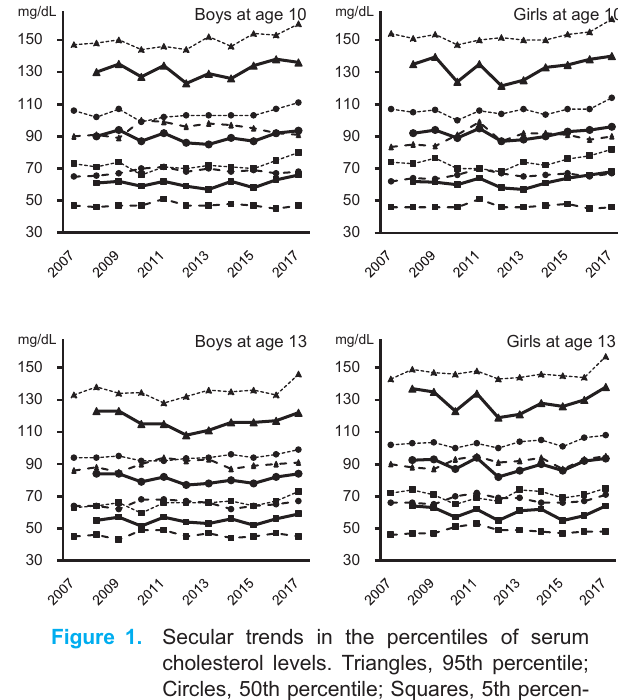
Figure 1. Secular trends in the percentiles of serum cholesterol levels. Triangles, 95th percentile; Circles, 50th percentile; Squares, 5th percen- tile; Solid lines, low-density lipoprotein choles- terol (LDL-C); Broken lines, high-density lipo- protein cholesterol (HDL-C); Dotted lines, non- high-density lipoprotein cholesterol (non-HDL- C). The Jonckheere-Terpstra test was used to evaluate secular trends, with calendar year as the explanatory variable and individual meas- urements as dependent variables. In children aged 10 years, signi fi cant increases were observed in LDL-C ( P = 0.009 in boys, 0.014 in girls), HDL-C ( P = 0.021 in boys, P < 0.001 in girls), and non-HDL-C ( P < 0.001 in both sexes). In children aged 13 years, signi fi cant increases were observed in non-HDL-C in boys ( P = 0.001) and girls ( P < 0.001), and in HDL-C in girls ( P =